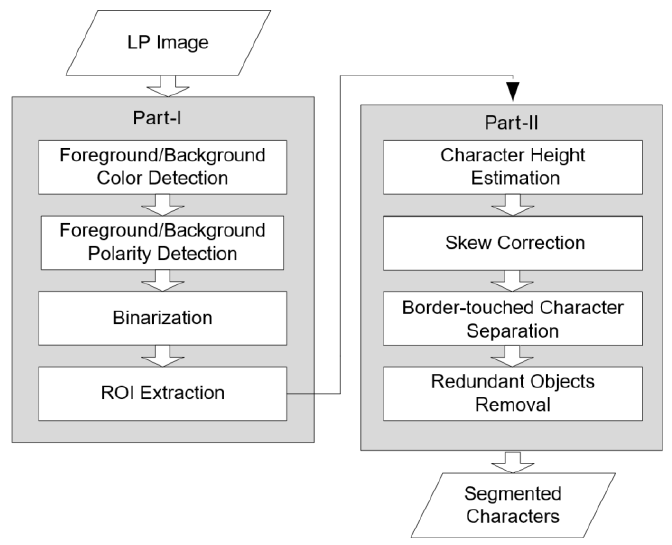
Figure 2. Proposed architecture for license plate character segmentation.